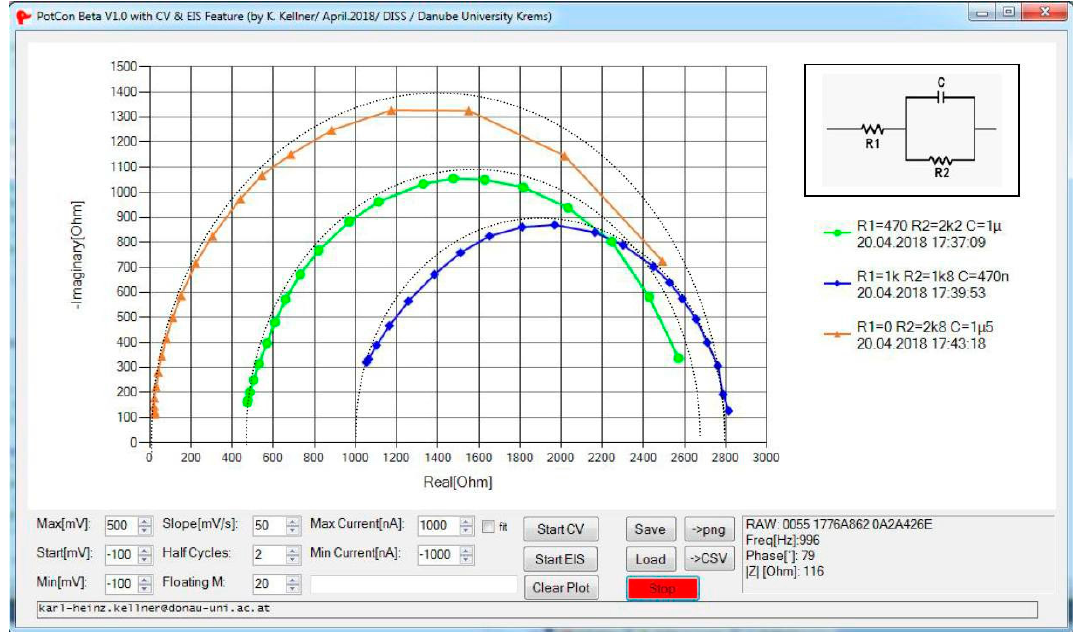
Figure 4. A demonstration of EIS, performed with the enhanced EcoStat device and presented with the PotCon GUI. The complex impedance Nyquist Plots of simplified Randles Cell under varying parameters are shown. Theoretical results are marked with dotted